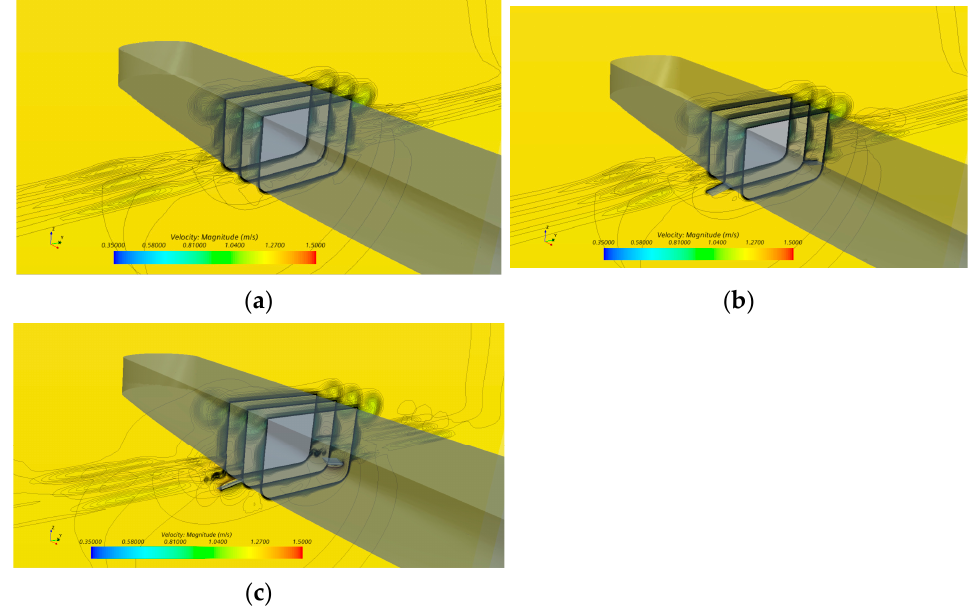
fins, at a 0° angle, and at a 20° angle.